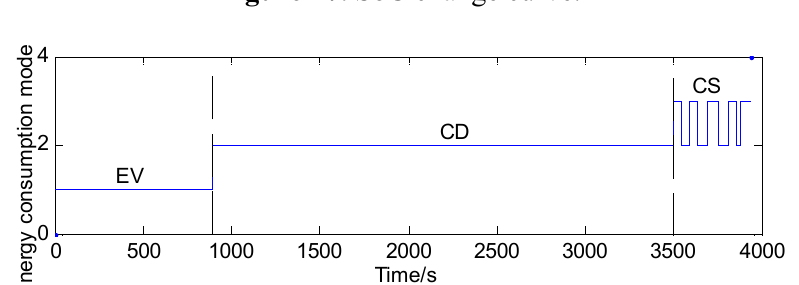
Figure 17. SoC change curve.